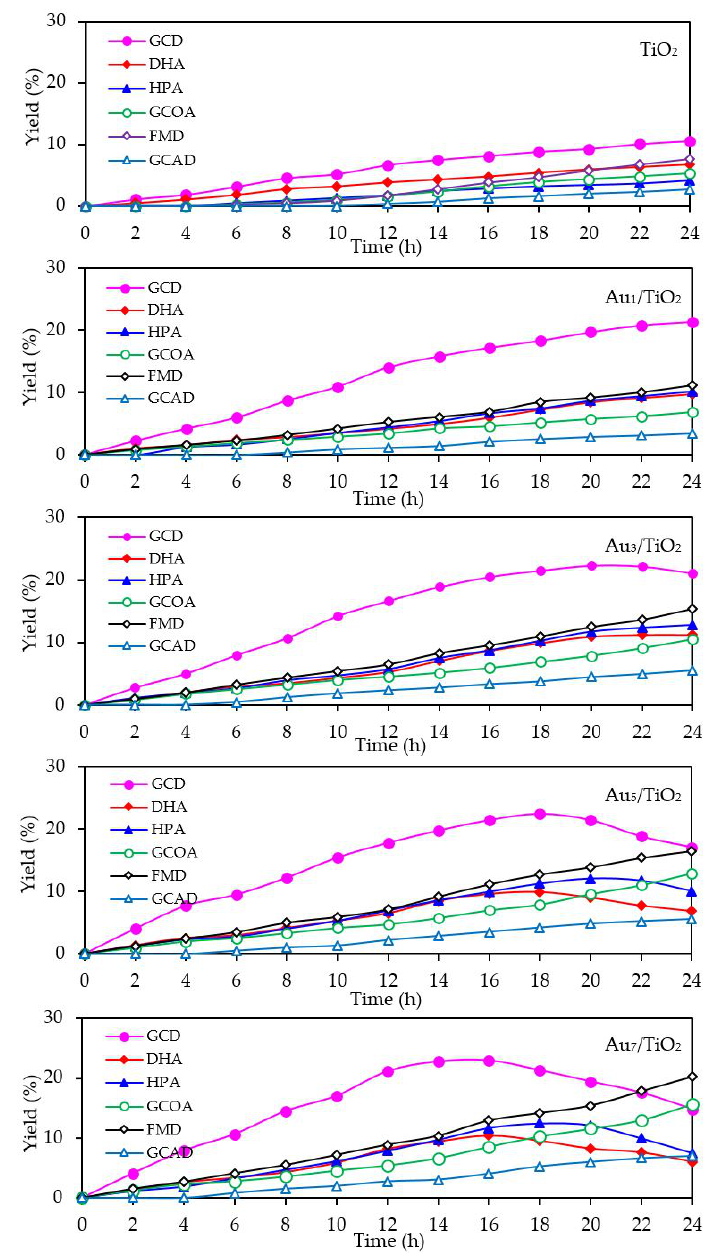
Figure 7. Yield of selected products obtained from the glycerol photocatalytic conversion via the TiO 2 and different Au x /TiO 2 photocatalysts at a loading of 3.0 g/L, light intensity of 4.7 mW/cm 2 and using O 2 as the electron acceptor.